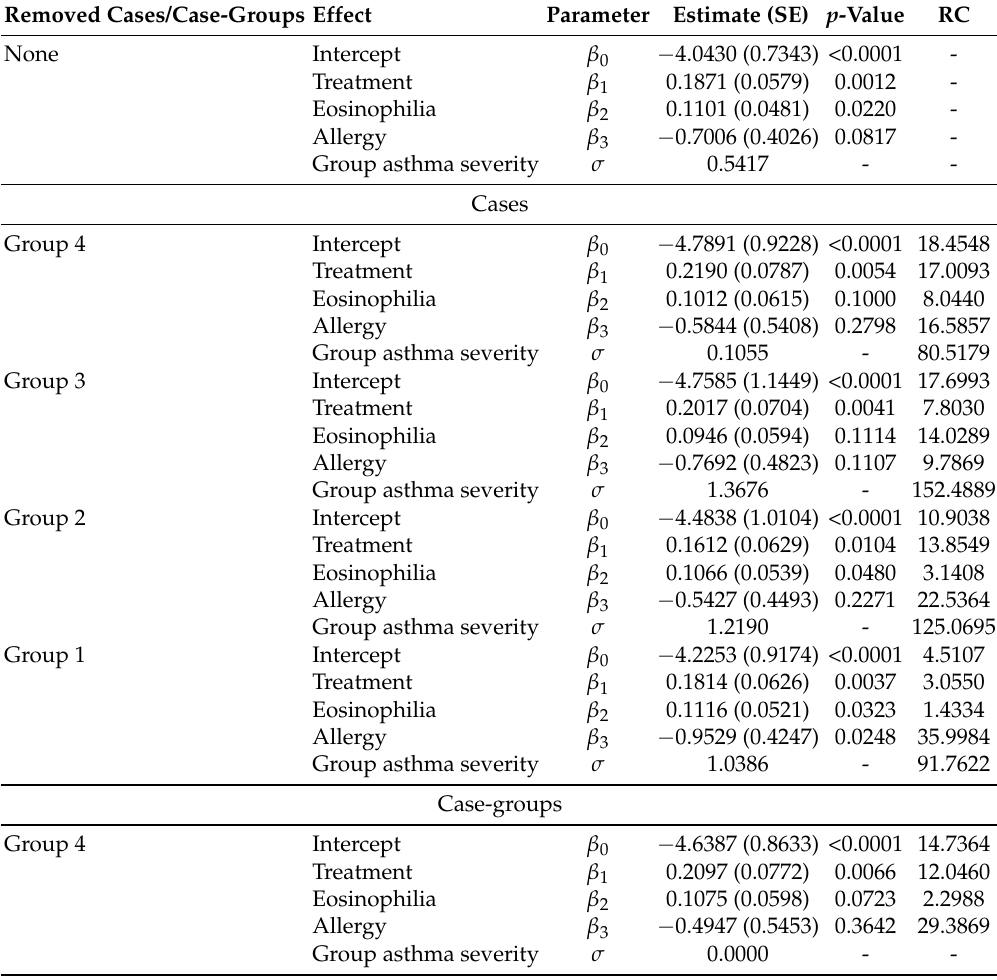
Table 4. Estimates (SE), p -values and RC under global influence diagnostics for the asthma data. Removed Cases/Case-Groups